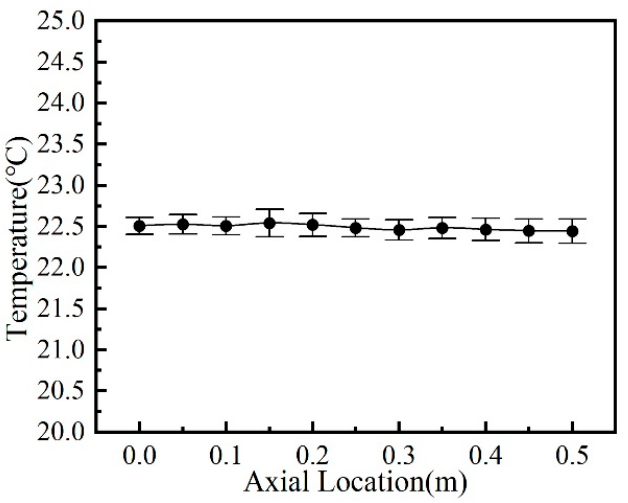
Figure 3. Exterior wall and inlet and outlet temperatures of the 4 × 4 mm channel when it is not heated.